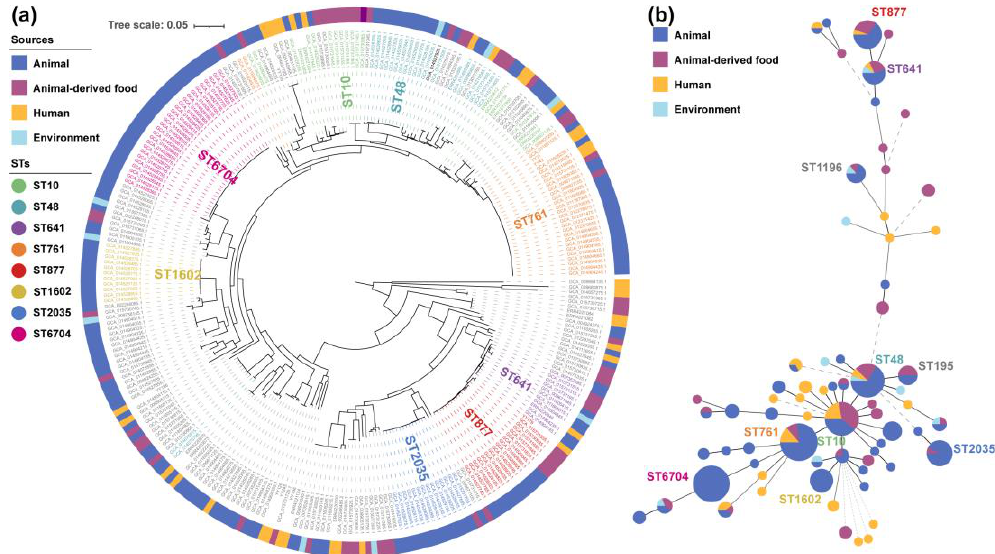
Figure 2. Phylogenetic tree (a) and minimum spanning tree (b) of 280 tet (X4)-positive E. coli .